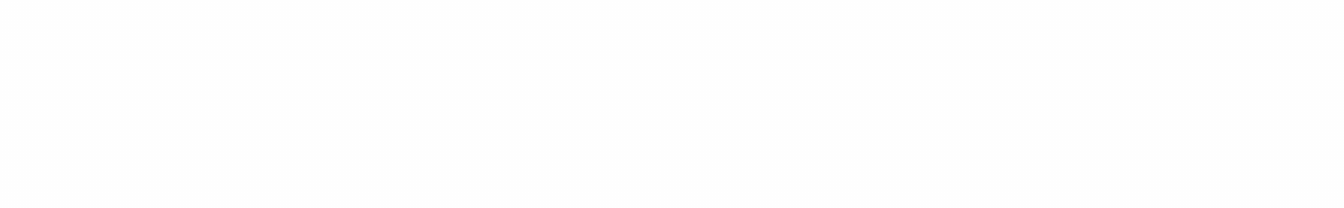
FIGURE 3 Comparison of simulated and actual locations of commerce, for simulation shown in Fig. 2. See Colour Plate